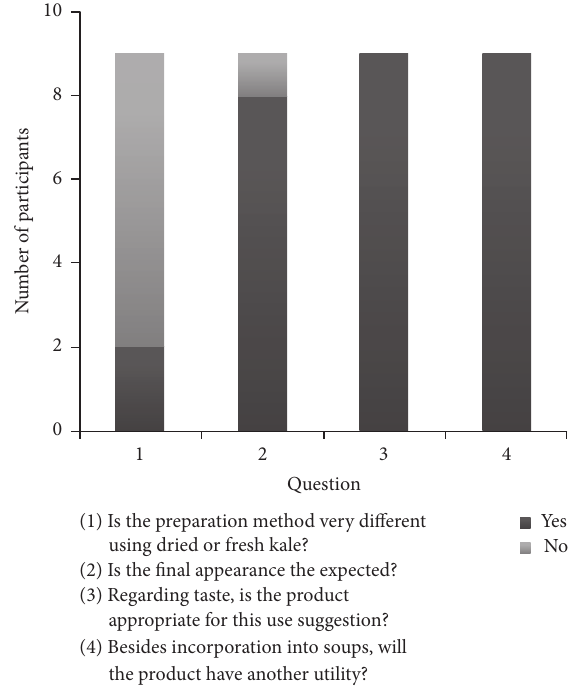
Figure 5: Results of the four questions presented in the question- naire filled after soup preparation at home, using galega kale steam blanched and dehydrated at 55 ∘